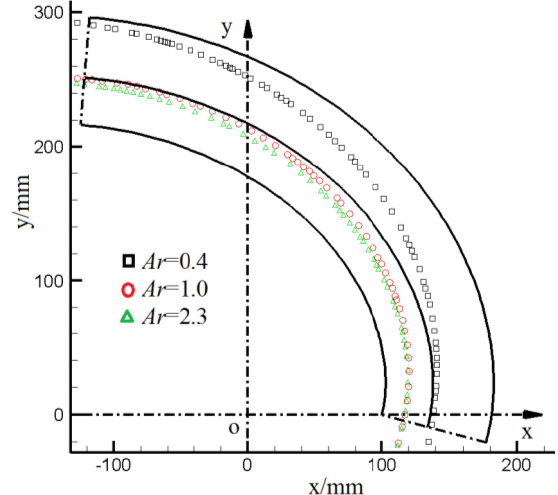
Figure 13. Effects of Ar on particle trajectory.